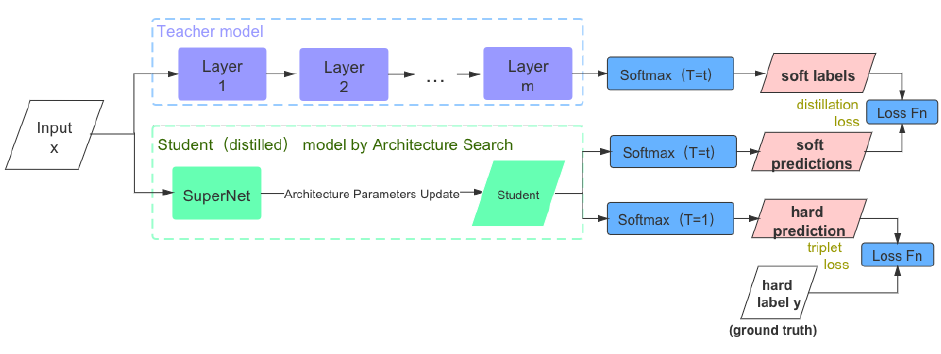
Figure 1. Knowledge distillation, which aims to transfer knowledge from the pre-trained teacher model to the student model by training a smaller, faster student model and making its output close to that of the teacher model after